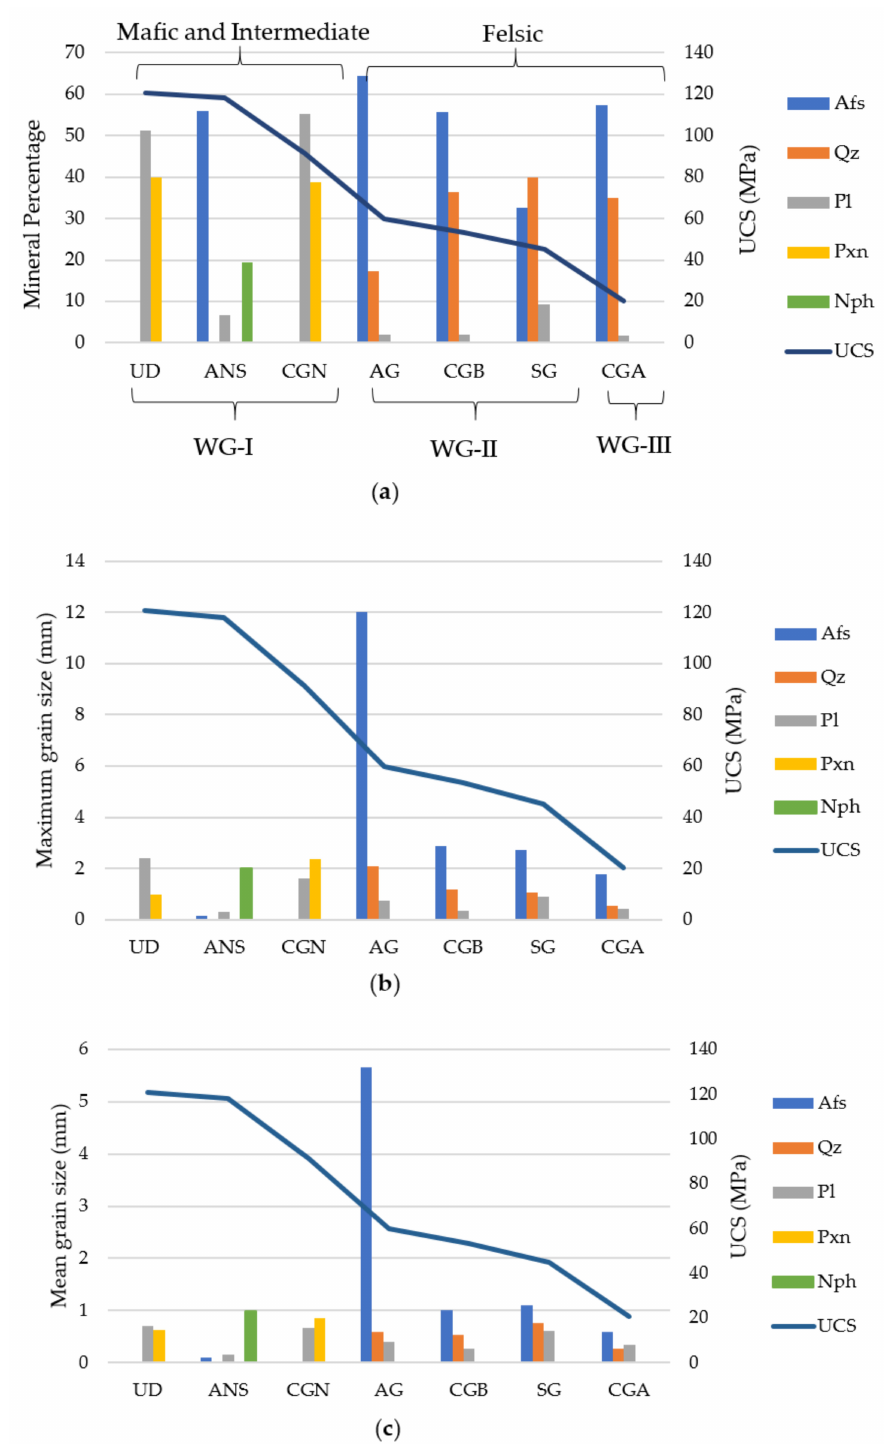
Figure 6. Relationship between the petrographic characteristics, weathering grade, and strength. ( a ) Effect of mineral composition and weathering grades on the strengths of mafic, intermediate, and felsic rocks. ( b ) Effects of maximum grain sizes of minerals and weathering grades on the strengths of mafic, intermediate, and felsic rocks. ( c ) Effects of mean grain sizes of minerals and weathering grades on the strengths of mafic, intermediate, and felsic